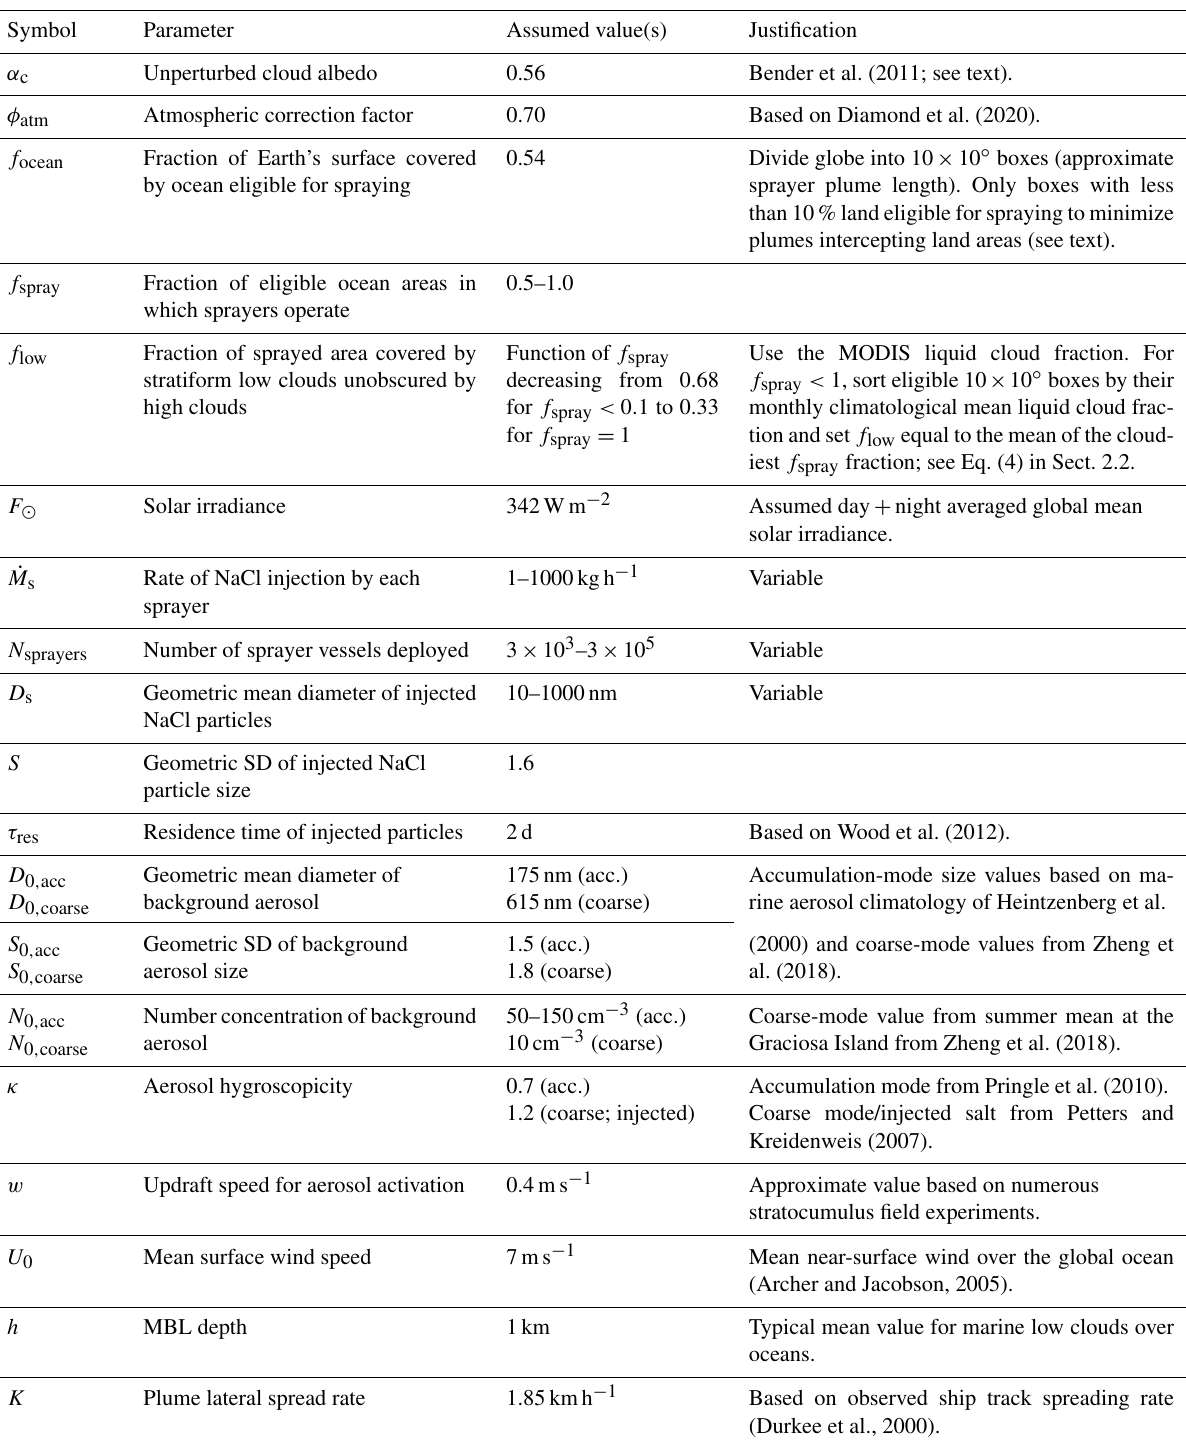
Table 1. Parameters used in the heuristic model and their assumed values. Note: SD – standard deviation; acc. –